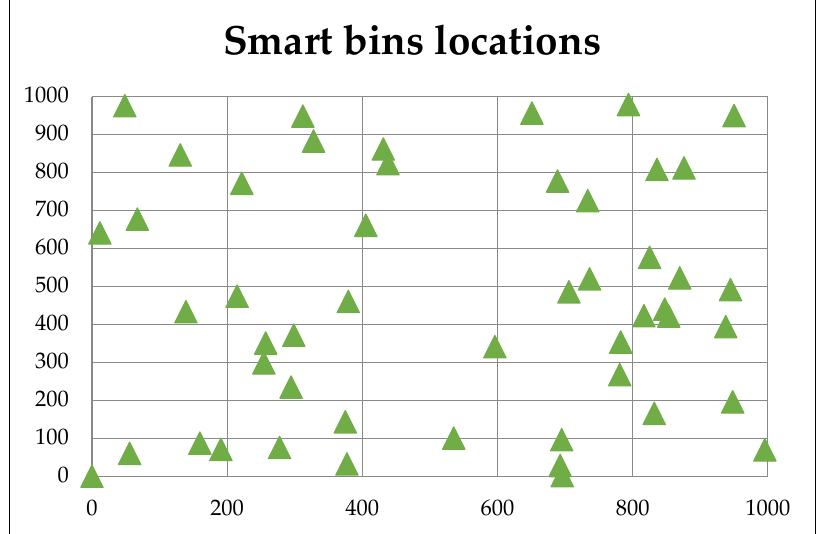
Figure 14. Smart bin location distribution.